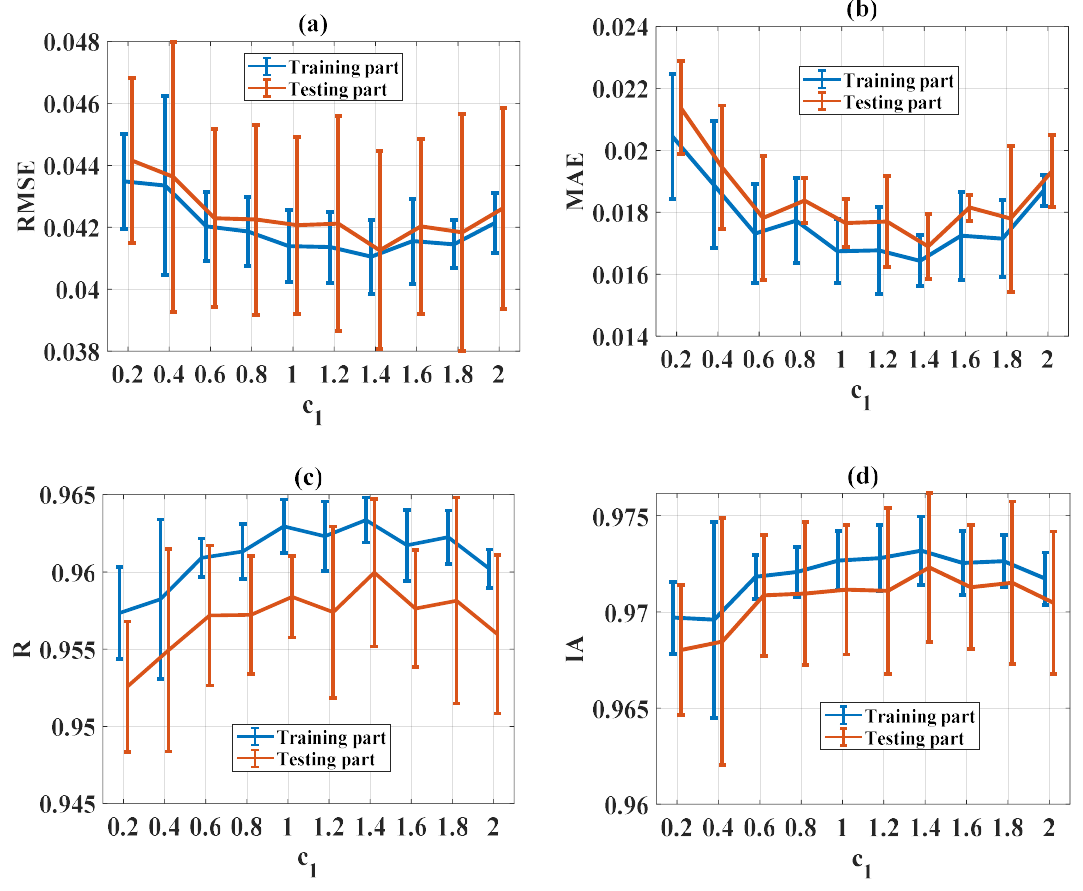
Figure 11. Evaluation of statistical criteria in the function of c 1 : ( a ) RMSE, ( b ) MAE, ( c ) R, and ( d ) IA.